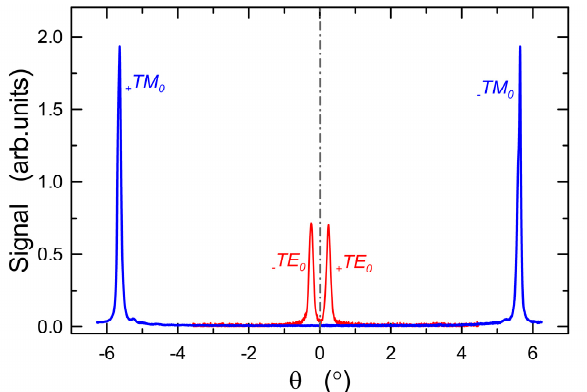
Figure 18. Modal spectra of the slab waveguide excited with the use of the grating coupler for fundamental modes, λ = 677 nm, Λ = 417 nm.